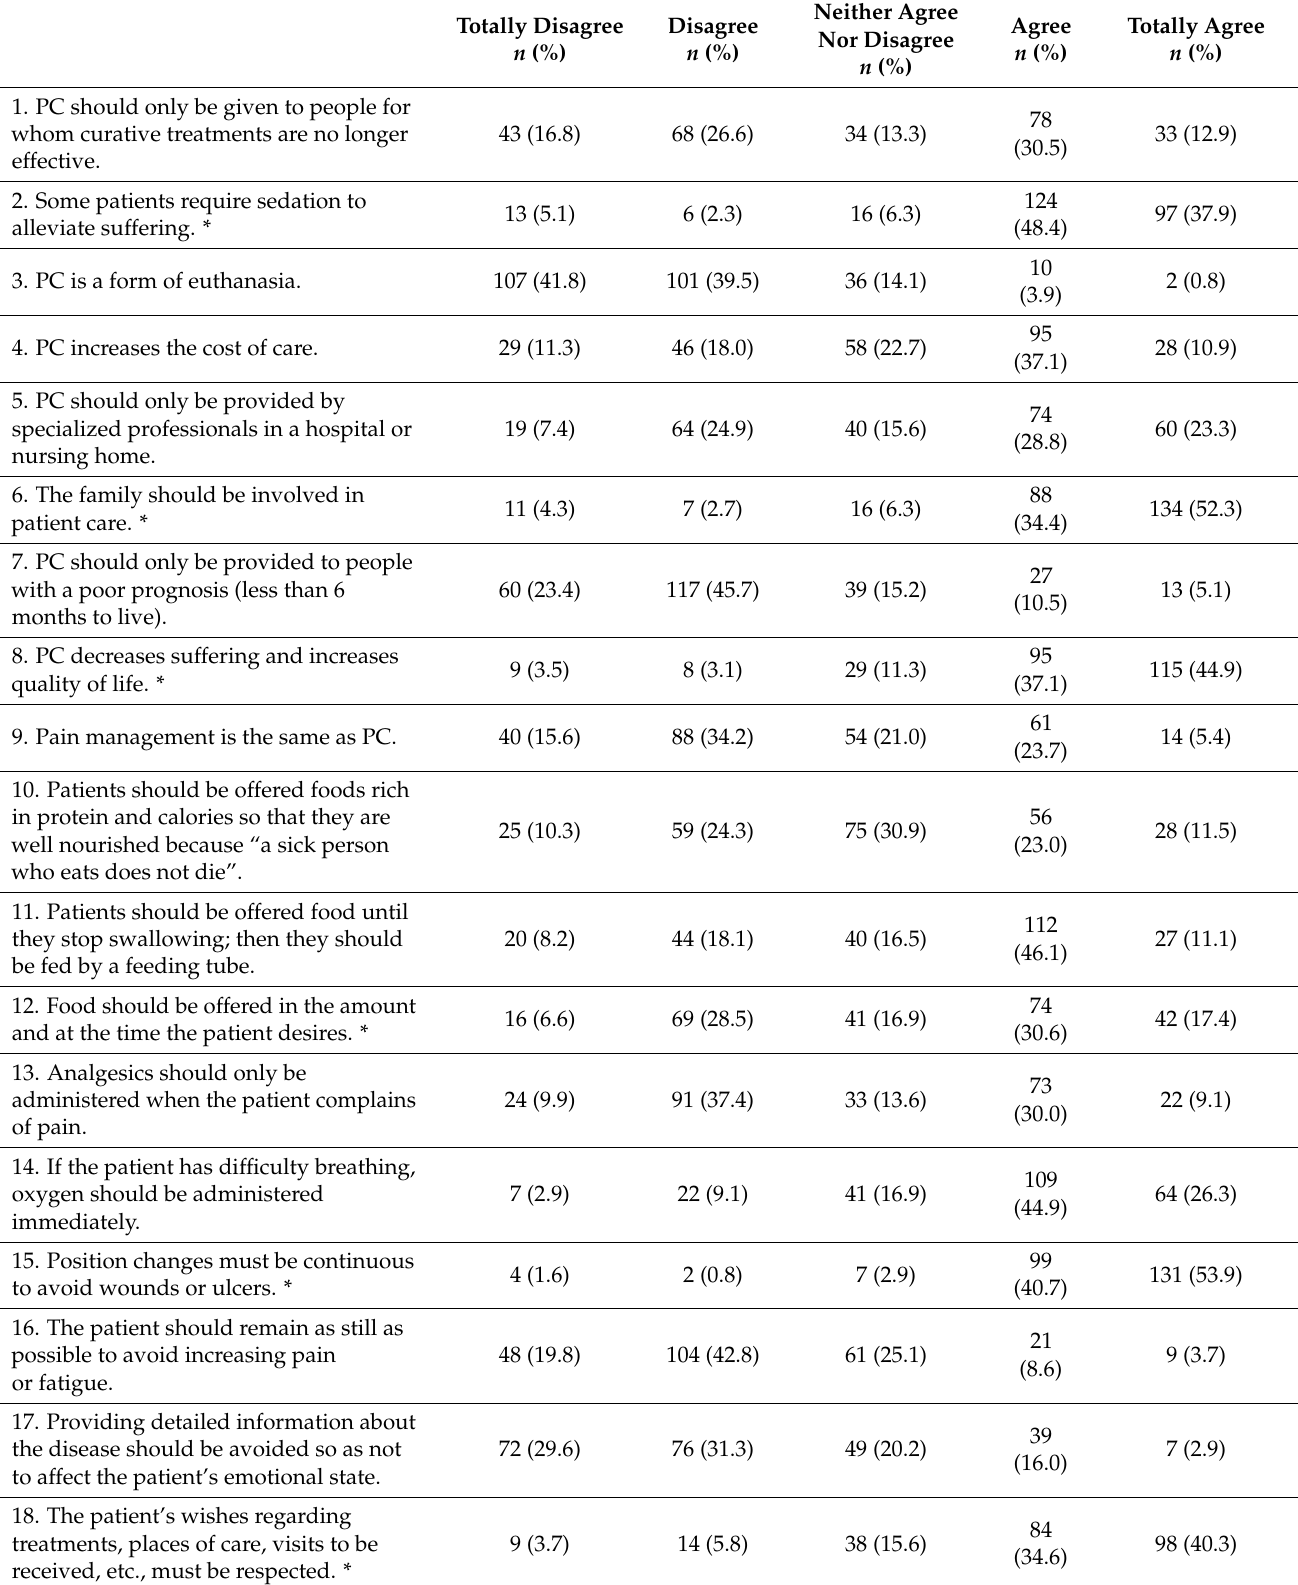
Table 1. Item responses of total PC knowledge